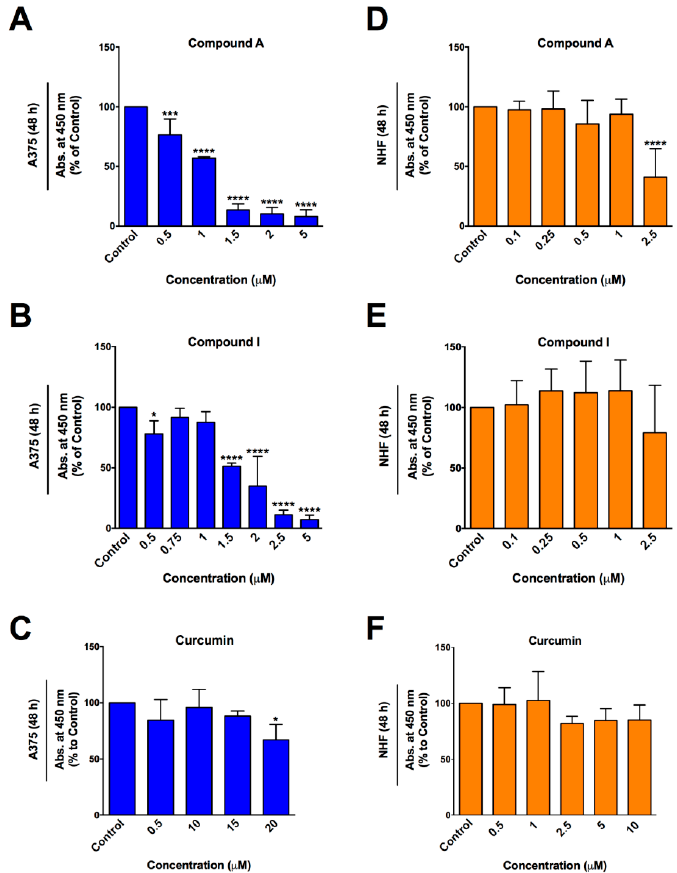
Figure 3. Compounds A and I selectively reduce cell viability in human melanoma cells. ( A–C ) A375 melanoma cells and ( D–F ) noncancerous normal human fibroblasts (NHF) were treated with Compound A, Compound I, and curcumin for 48 h. The WST-1 assay was performed as described in the materials and methods section. A375 cell viability data from Figure 1 were re-plotted as bar graphs to produce Figure 3 (A–C). Values are expressed as a mean ± SD from at least three independent experiments. The x -axis represents concentration ( µ M) and the y -axis represents absorbance (% of